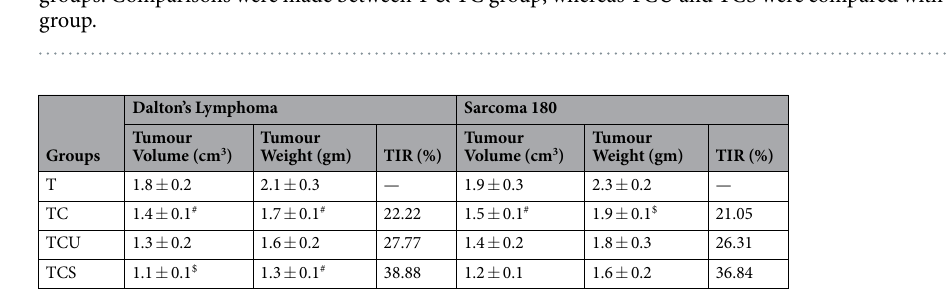
Table 3. Effect of MUS on growth of two different ascites tumours in vivo . Data are represented as mean ± SD, n = 6. * Denotes (P < 0.001), # denotes (P < 0.01) and $ denotes (P < 0.05) as compared to their respective control groups. Comparisons were made between T & TC group; whereas TCU and TCS were compared with TC group.